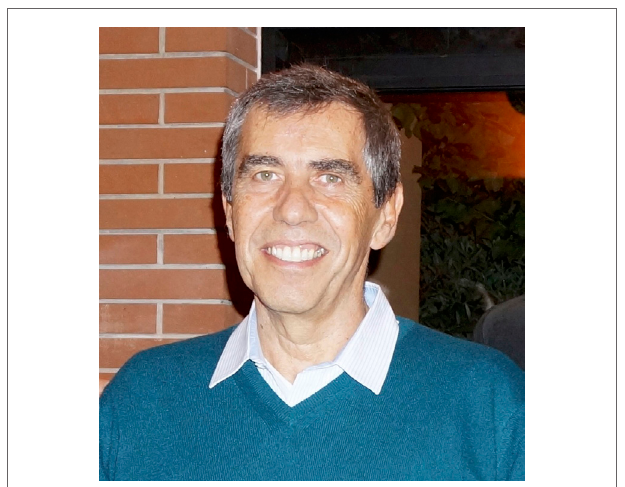
Figure 1 | Prof. Alessandro Moretta